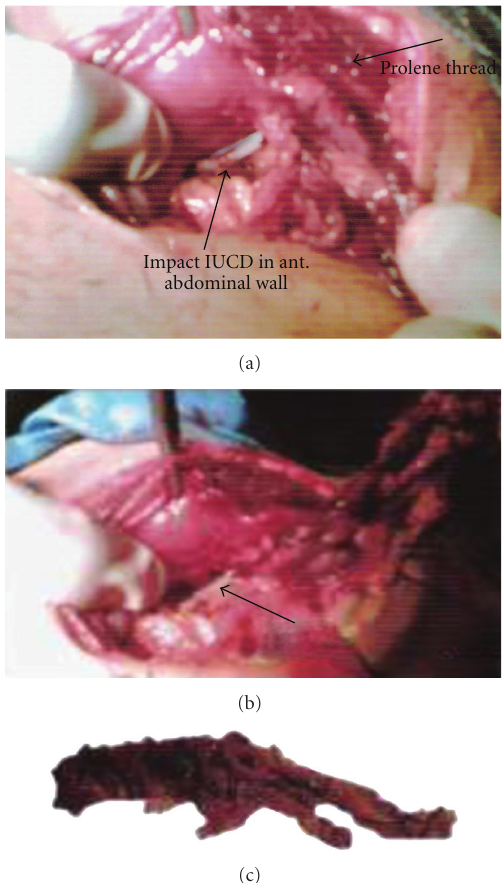
Figure 2: (a) and (b) Intraoperative figure showing impacted IUCD. (c) Showing retrieved